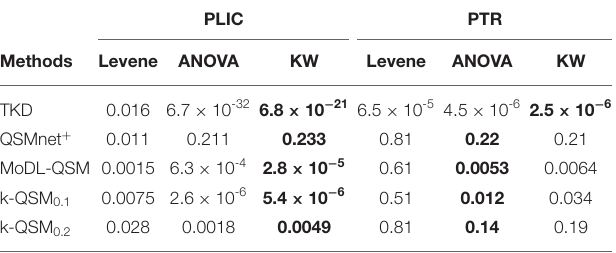
TABLE 2 | Comparison of p-values of Leven, ANOVA, and Kruskal–Wallis (KW) tests on the results of five orientations using several methods in regions of posterior limb of the internal capsule (PLIC) and posterior thalamic radiation (PTR) of white